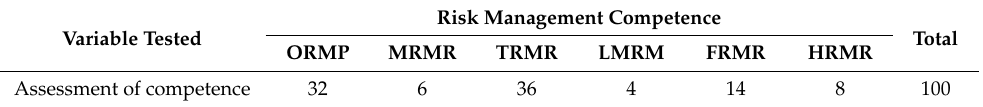
Table 1. Percentage distribution of the six core competence areas of corporate resource manage- ment risk.